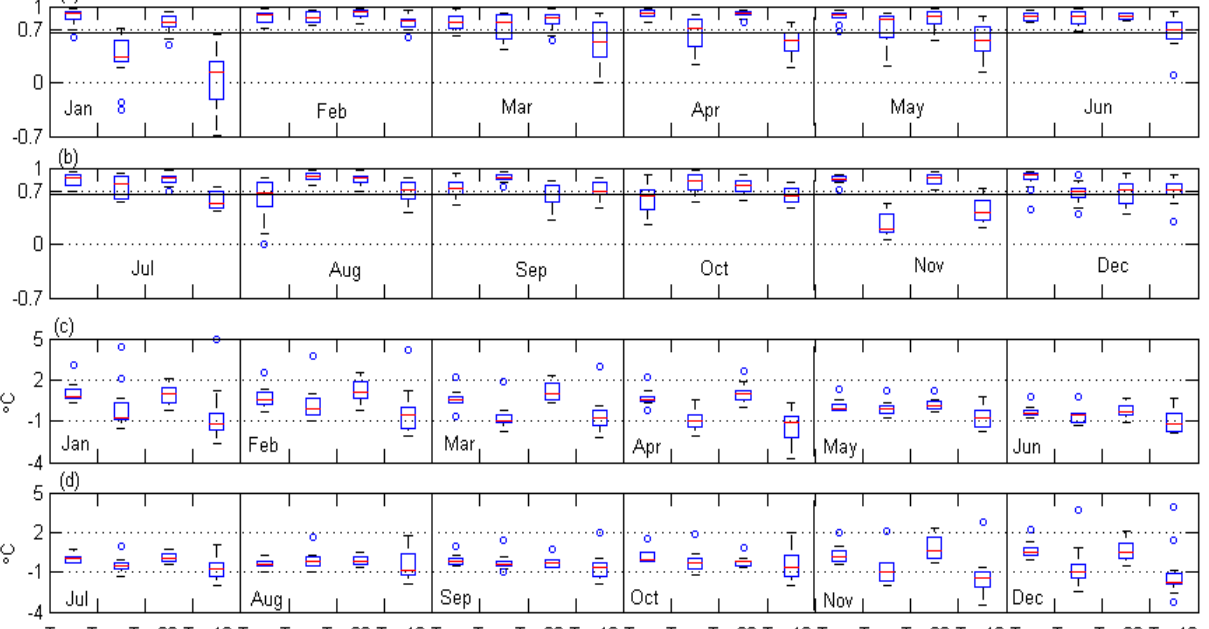
Fig. 2. Correlations (a–b) and differences (c–d) between the simulated and the observed extreme temperature indices for each month during the validation period 1981–1990. The whisker-box plots depict the range of the correlation across 13 stations. The boxes denote the median and interquartile range (IQR). Whiskers extend 1.5 IQR from box ends, with outliers denoted as circles. The horizontal solid line denotes significant correlation at the 5% confidence level.